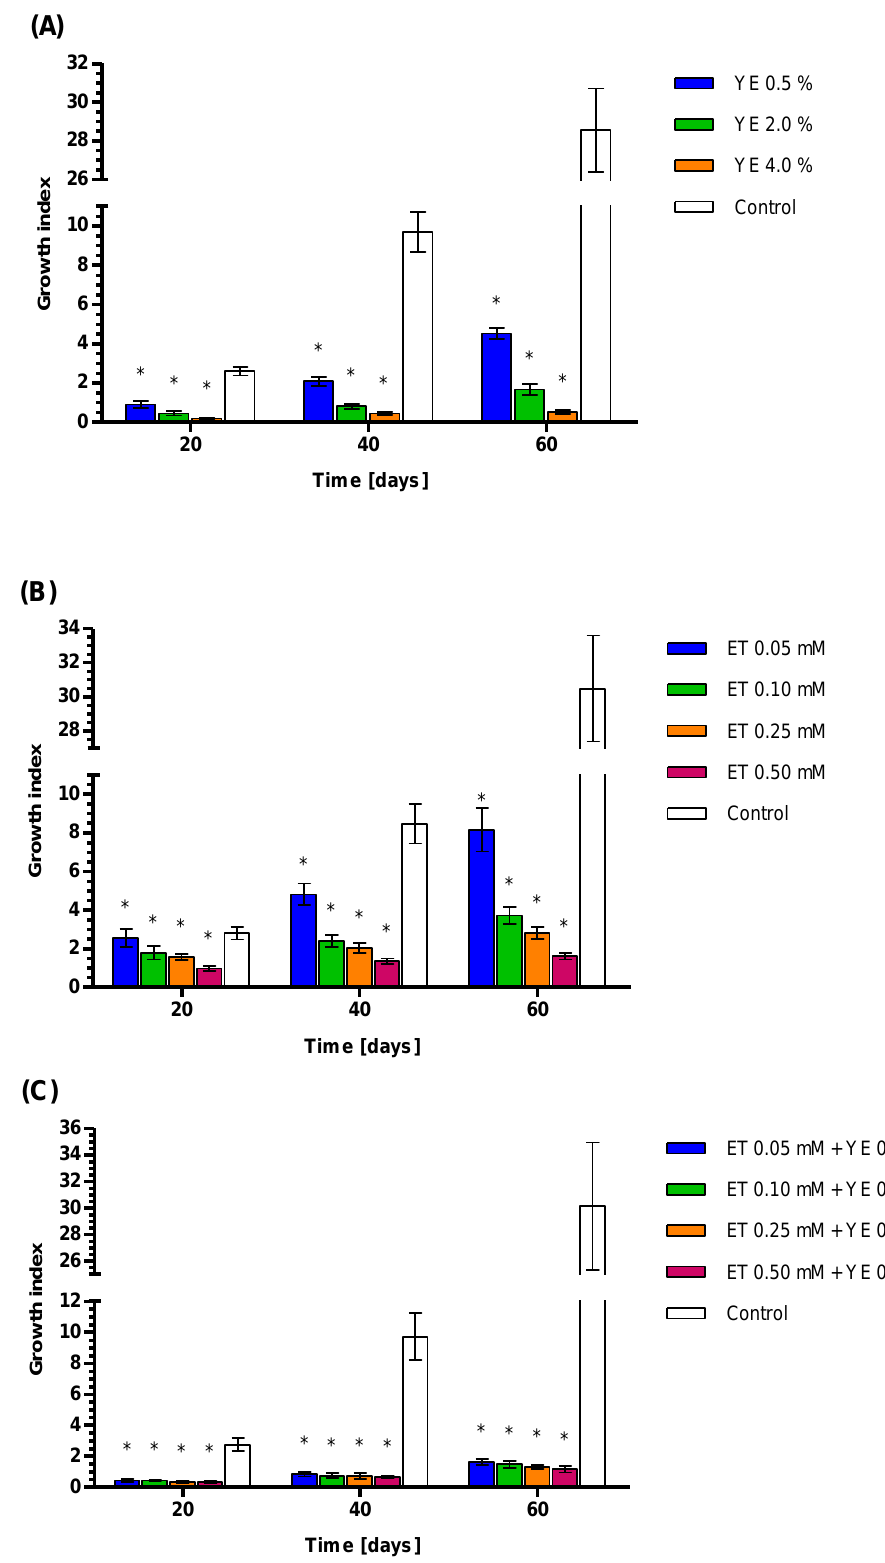
Figure 3. Growth index for fresh S. miltiorrhiza callus after treatment by 0.5, 2.0, 4.0% YE ( A ), 0.05, 0.10, 0.25, 0.50 mM ET ( B ), 0.5% YE plus 0.05, 0.10, 0.25, and 0.50 mM ET ( C ). Results presented as mean +/ − standard deviation. Differences between control and tested values were statistically significant according to the Wilcoxon signed-rank test at p < 0.01. Significant results were marked by an asterisk (*).